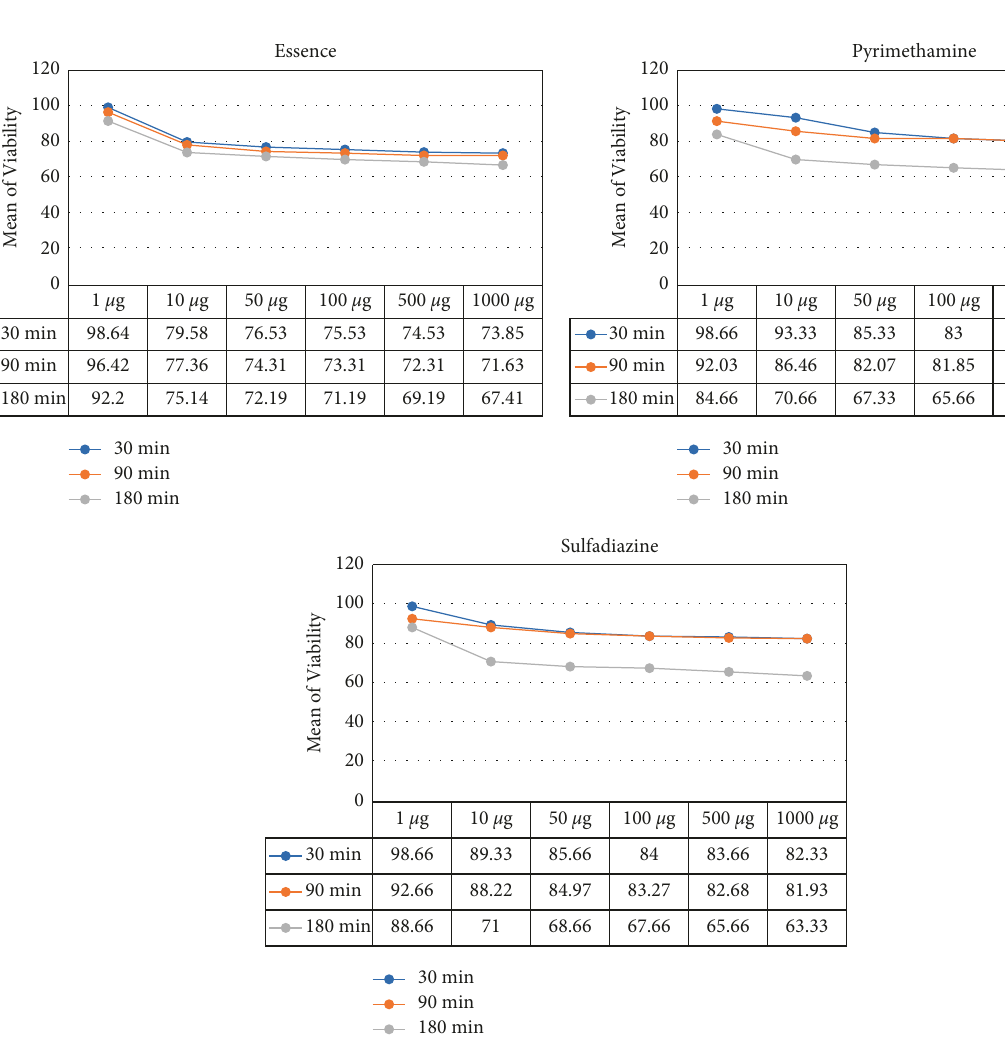
Figure 1: Mean of viability in pyrimethamine, sulfadiazine, and essential oils.